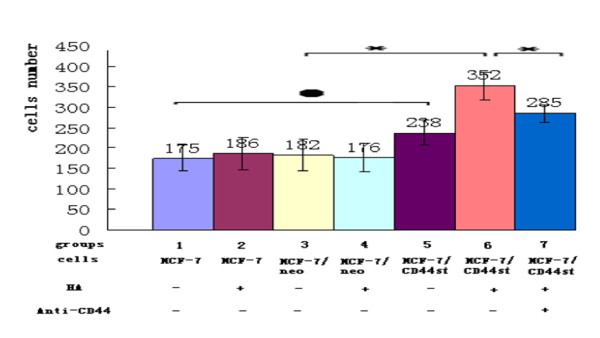
CD44st and hyaluronan interaction leads to an increase in MCF-7/CD44st invasion capabilities. The invasive capability of the tumor cells was assayed in the presence (+) and absence (-) of HA (100 μg/ml) for 24 h with transwell pretreated filters. Cells in the pretreatment with CD44 blocking antibody groups were pretreated with anti-CD44 (20 μg/ml) for 3 h, and then treated with HA (100 μg/ml) for 24 h. ● P > 0.05, *P < 0.05.